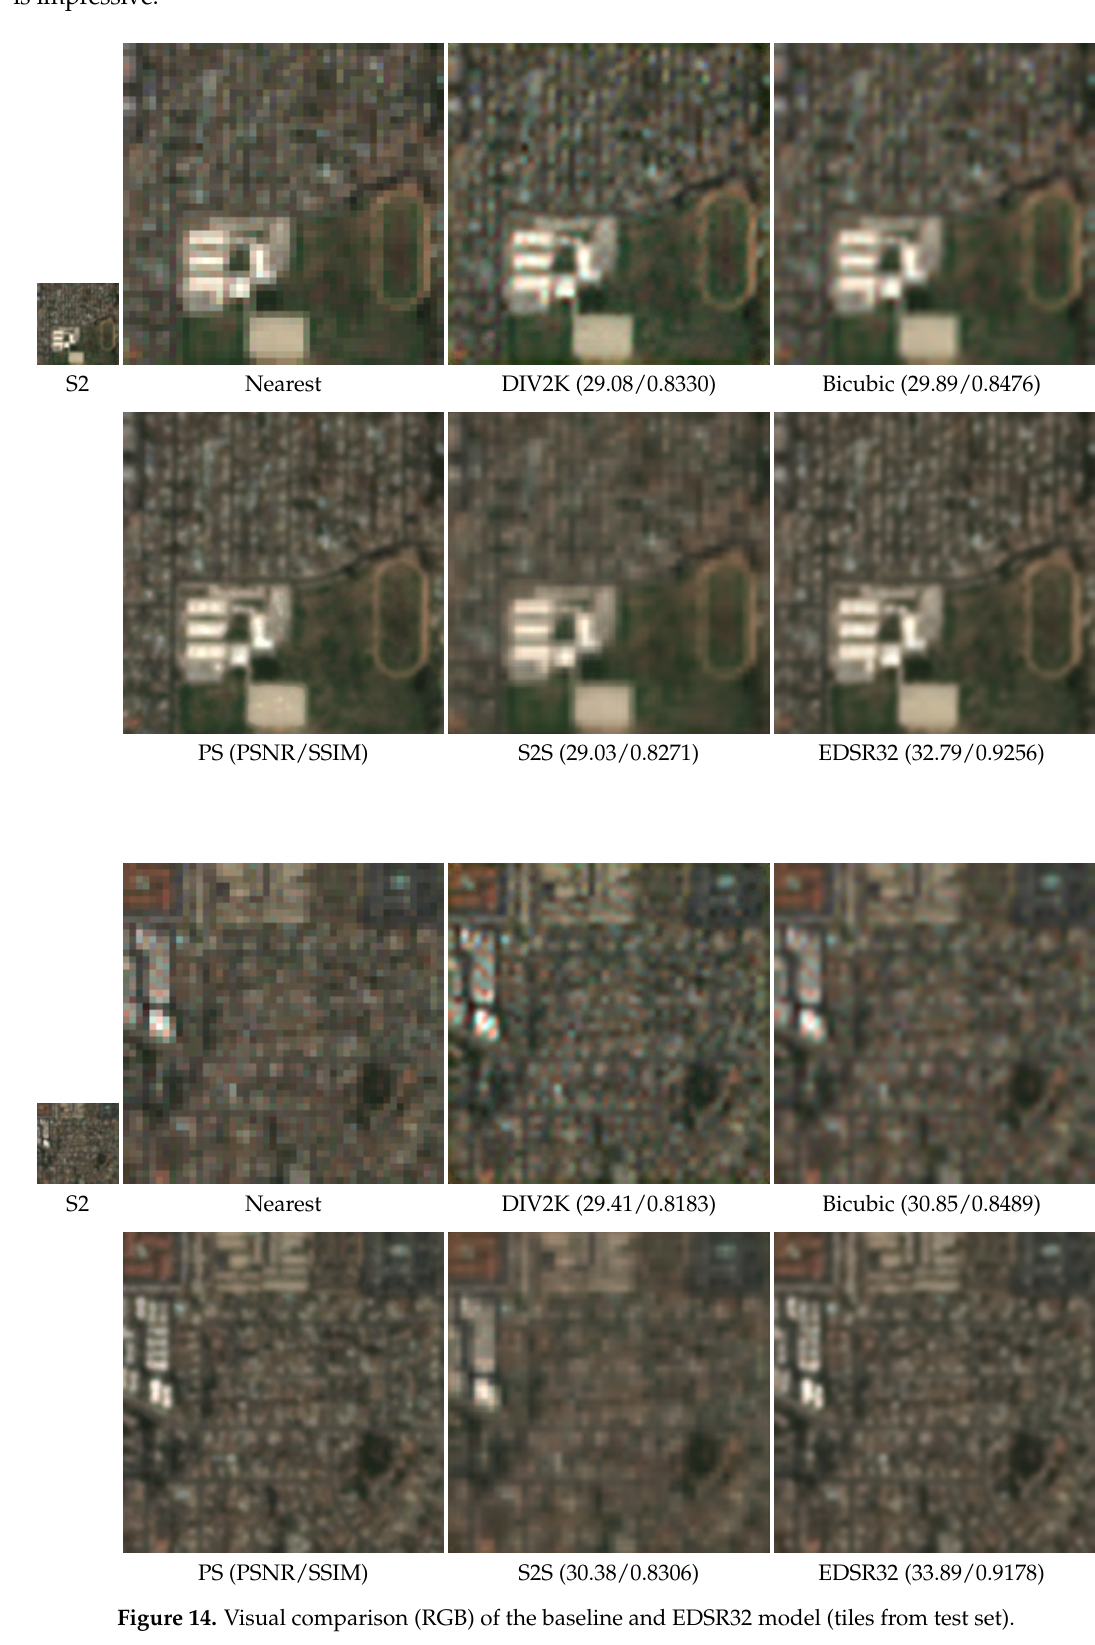
Figure 14. Visual comparison (RGB) of the baseline and EDSR32 model (tiles from test